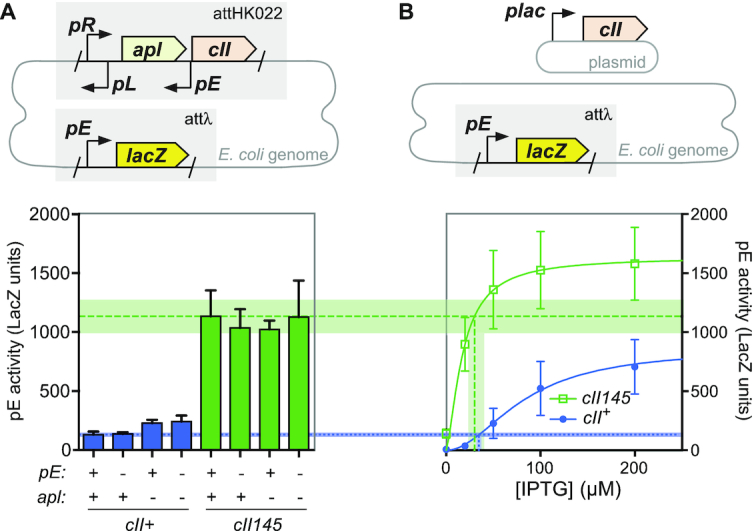
Steady-state CII activity. (A) The activity of CII expressed from the pR promoter in the absence of CI (upper module) was assayed by a pE.lacZ reporter in trans (lower module) by β-galactosidase assay at steady state. Bars show mean and standard deviation (n ≥ 11). (B) The activity of CII expressed with IPTG induction from pZS45-CII169 or pZS45-CII145, assayed by the same reporter, as reported in (10). The plot shows the mean, standard deviation (n ≥ 6) and Hill fits.